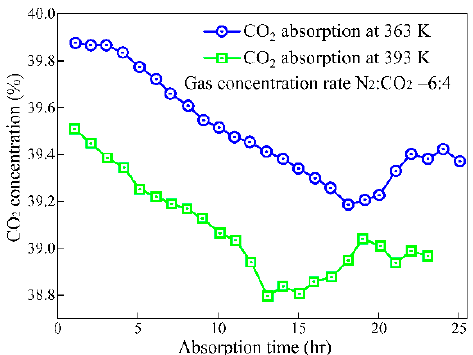
Figure 8. Evaluation of CO 2 absorption properties of LiBO 2 with gas chromatography method. Temperature (K)